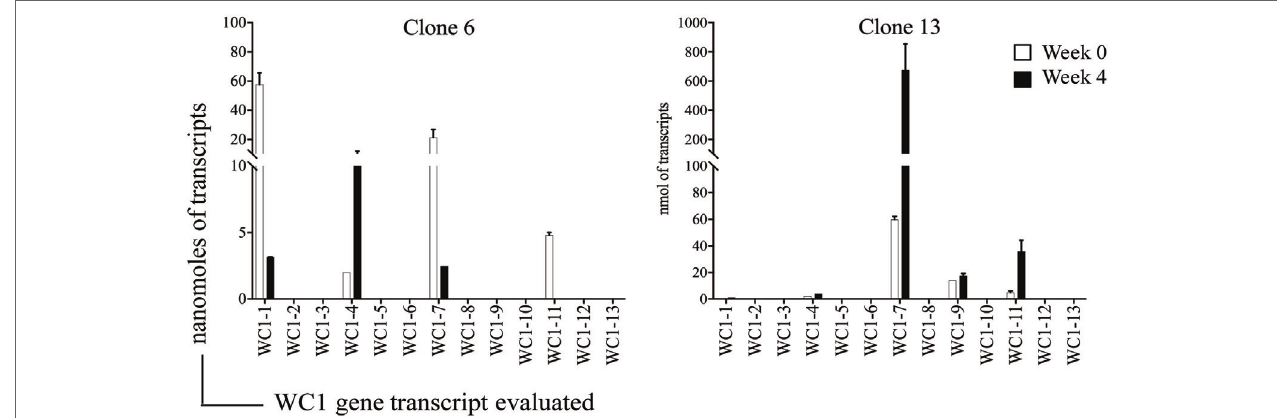
FigUre 4 | Time-course evaluation of WC1 gene transcription. Evaluation of WC1 gene transcription by selected clones at two different time-points 4 weeks apart are shown. Filled bars show earlier time point and open bars the later. Transcripts are represented as moles of the mean ± SE of replicates. This was done three times with triplicate